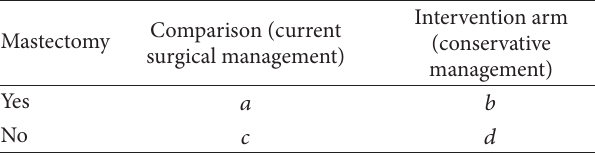
Table 2: Secondary outcome: comparison of mastectomy